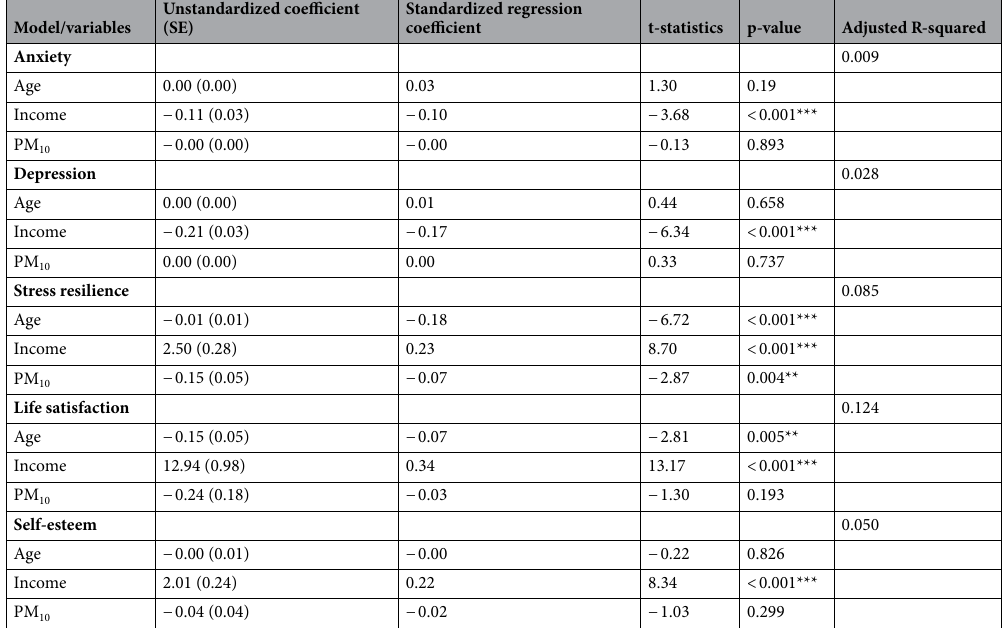
Table 3. Regression analyses predicting mental health and well-being determinants for males. Dependent variables anxiety, depression, stress resilience, life satisfaction and self-esteem. PM 10 particulate matter 10 µg/ m 3 , SE standard error. *p < 0.05, ** p < 0.01, *** p < 0.001.